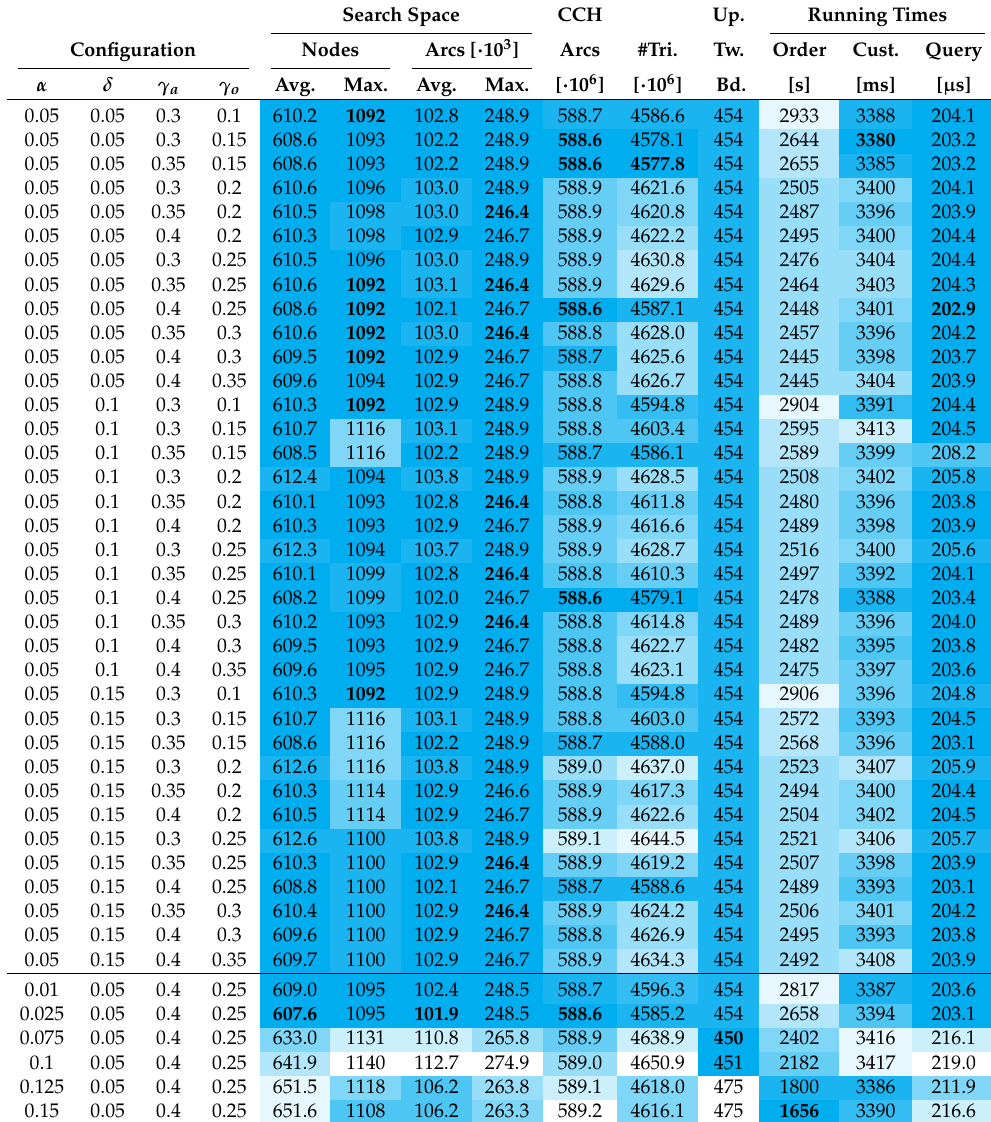
Table 8. CCH performance of different parameter configurations of IFC8 on Europe. Bold values are the best in their category. Darker shades indicate better values. Search Space CCH